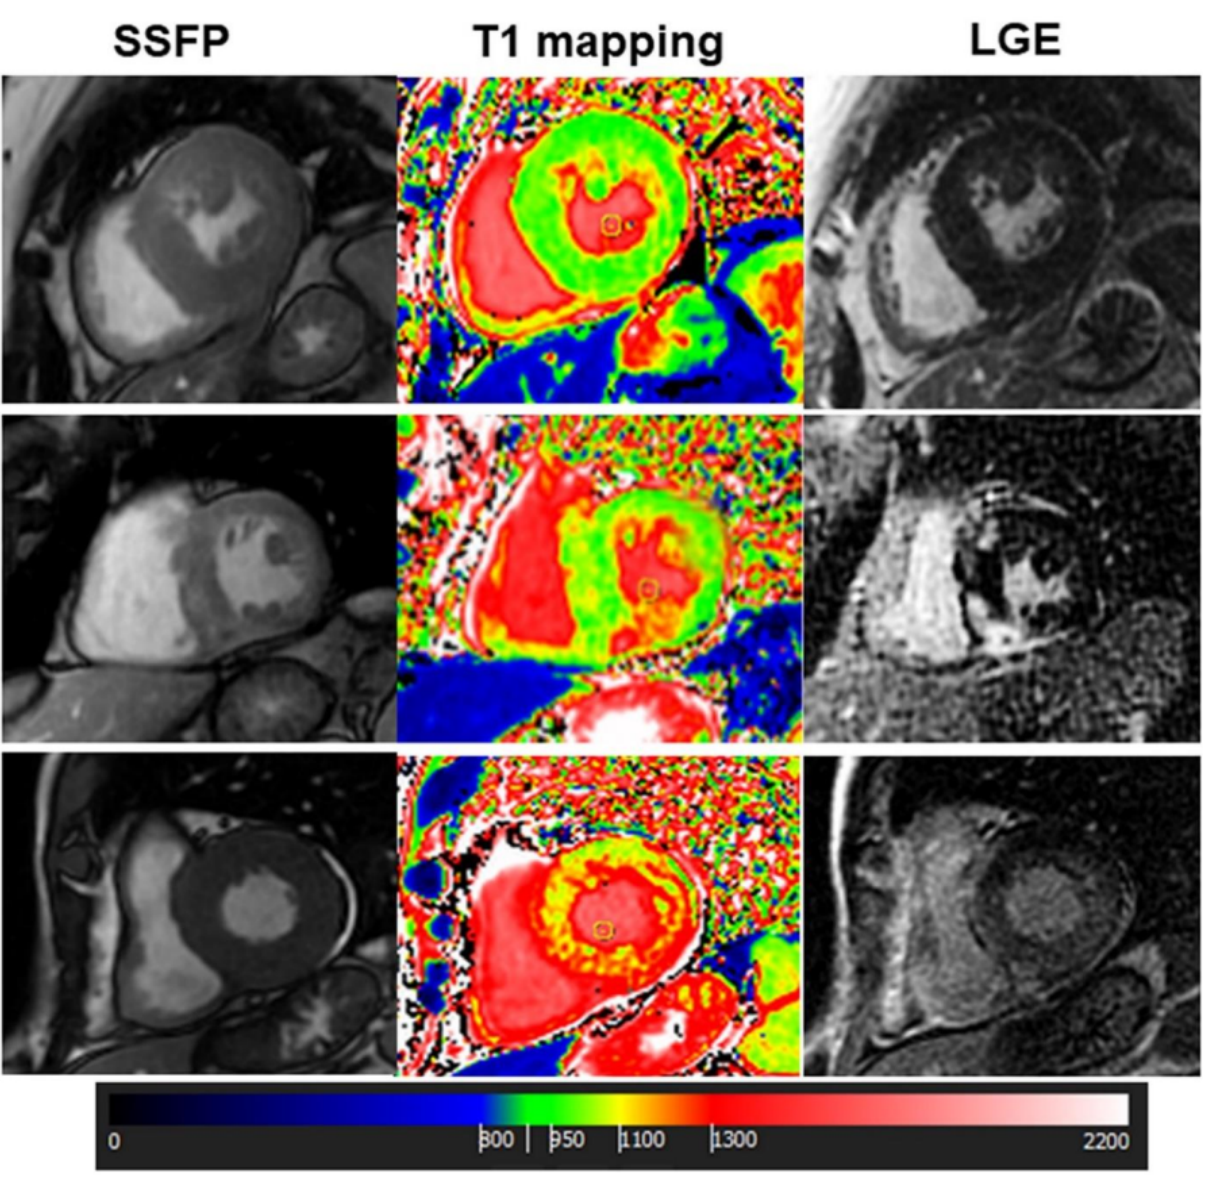
Figure 2. Cardiac Magnetic Resonance of 3 different cases of left ventricular hypertrophy: The upper panels show a case of hypertensive left ventricular hypertrophy (LVH) with concentric hypertrophy, normal native T1 values and negative late gadolinium enhancement (LGE). The middle panels show a case of hypertrophic cardiomyopathy (HCM) with asymmetrical LVH, focal areas of myocardial fibrosis at LGE and focal increase in native T1 corresponding to the fibrotic areas. Finally, a case of cardiac amyloidosis is reported in the lower panels. In this case, LVH is concentric, native T1 is diffusely increased and a diffuse subendocardial enhancement was found at LGE. SSFP, steady state free